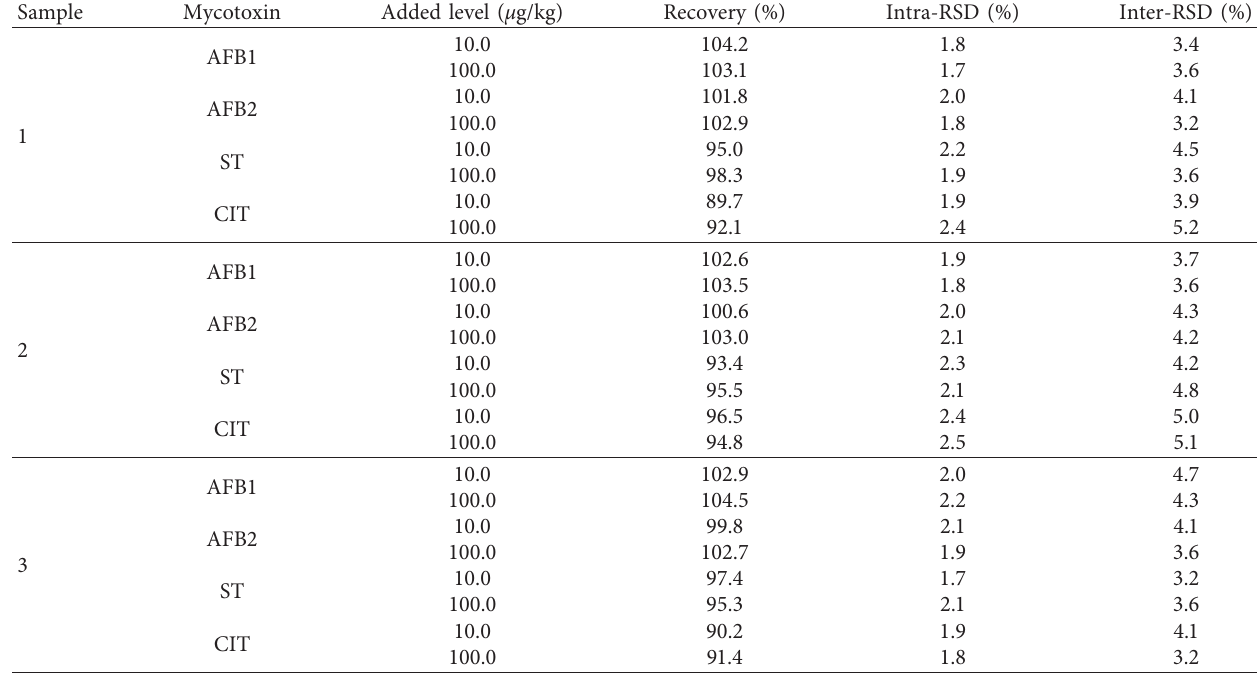
Table 2: Analytical results of